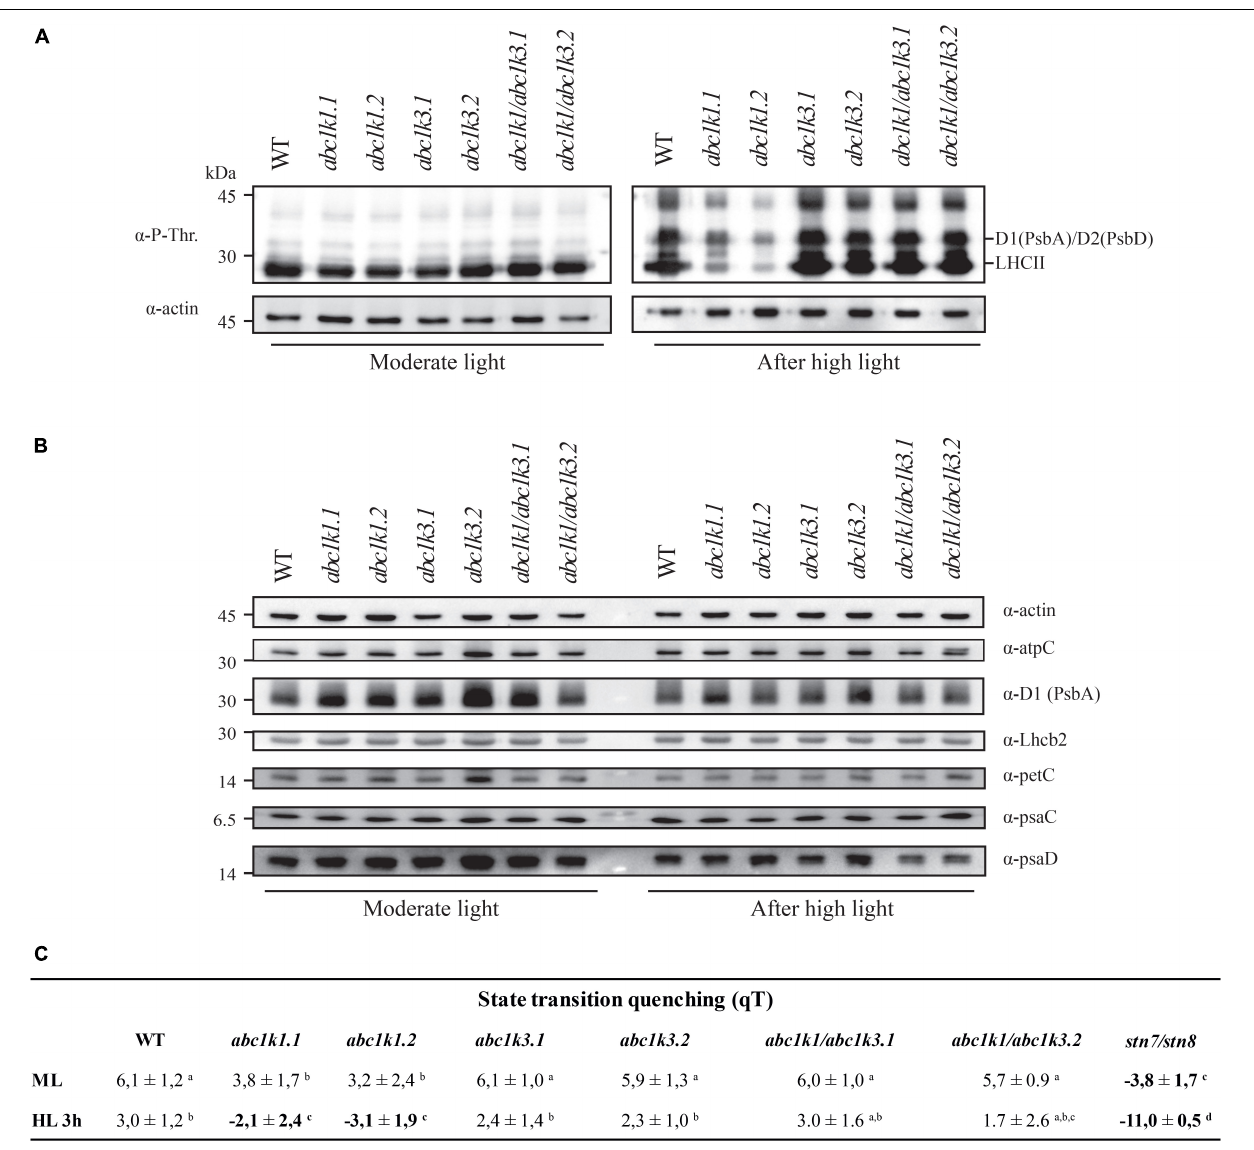
FIGURE 7 | Double mutant maintains thylakoid protein phosphorylation and state transitions after high light. (A) Total protein extracts of wild type (WT), abc1k1.1, -2, abc1k3.1, -2, and abc1k1/abc1k3.1, -2 light-exposed leaves were separated by SDS PAGE, transferred on nitrocellulose membrane and decorated with anti-phosphothreonine antibody. The main thylakoid phospho-proteins are indicated on the right according to their size. Core photosystem II proteins D1 (PsbA) and D2 (PsbD) are indicated together due their poor resolution. (B) The accumulation of the principal photosynthetic complexes was assessed using antibodies against specific subunits of each complex: anti-Lhcb2 for the major LHCII, anti-D1 (PsbA) for PSII, anti-PetC for cytochrome b6f , anti-PsaD and anti-PsaC for PSI, and anti-AtpC for ATP synthase. Actin signal is shown as a loading control. (C) Fluorescence quenching related to the state transitions (qT) of wild type (WT), abc1k1.1, -2, abc1k3.1, -2, and abc1k1/abc1k3.1, -2 under moderate light (120 µ mol of photons m − 2 s − 1 ) (ML) and after 3 h of high light (500 µ mol of photons m − 2 s − 1 ) (HL). qT was calculated from the maximal chlorophyll fluorescence measured after 10 min exposure to red light (660 nm) supplemented with far-red illumination (720 nm) “State 1” (F M ST1) or to pure red light “State 2” (F M ST2). Quenching related to state transition was calculated as qT = (F M ST1 – F M ST2)/F M . Each value represents the average of a pot containing 2–3 plants. Superscript letters are used to indicate statistically different groups ( p < 0.05) by paired Student’s t